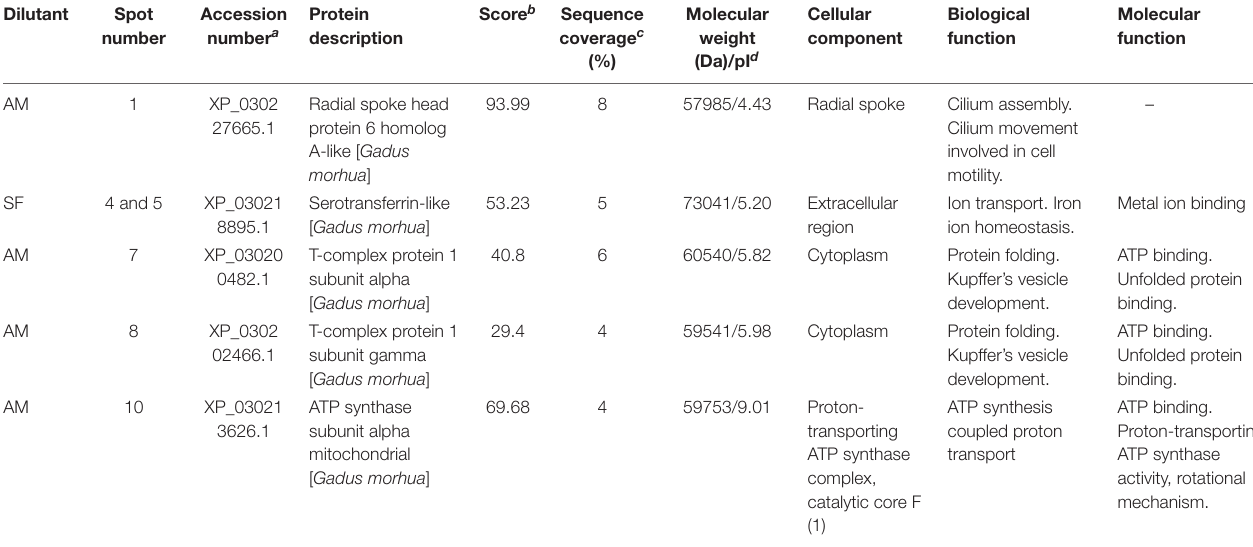
TABLE 4 | Differentially expressed proteins in burbot spermatozoa diluted in seminal fluid (SF) and activation medium (AM).